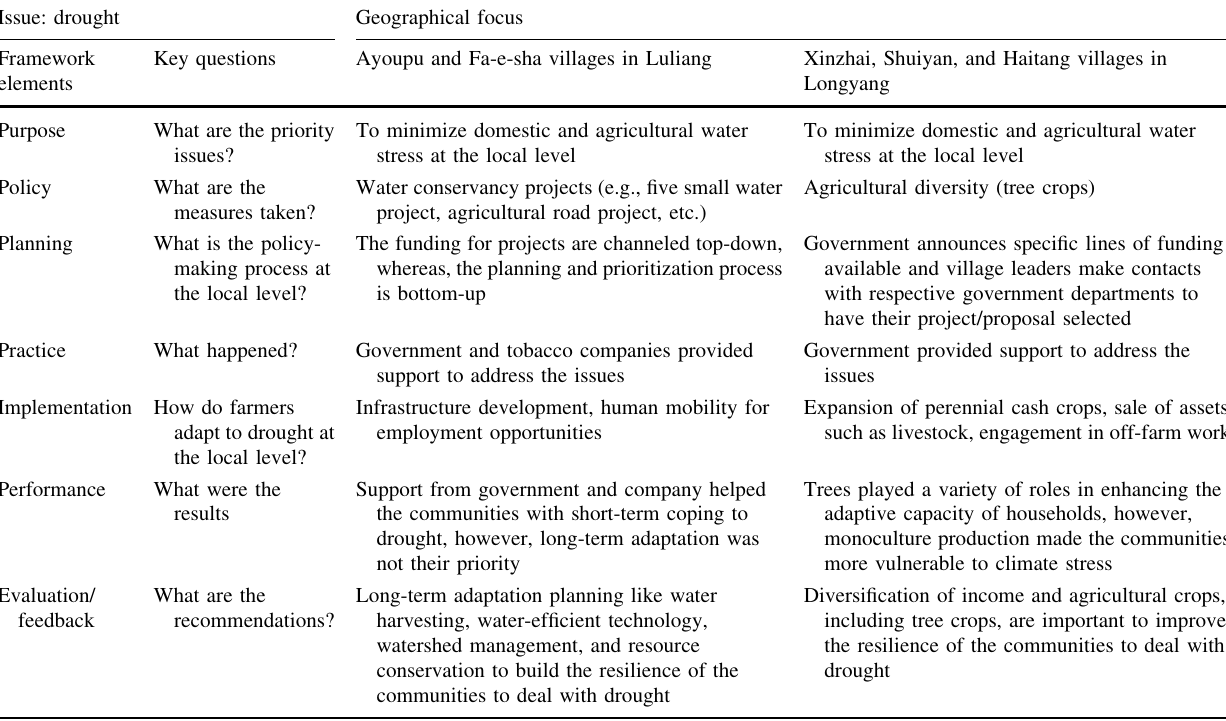
Table 2 The effectiveness of policy implementation analyzed using the modified framework Issue: drought Geographical